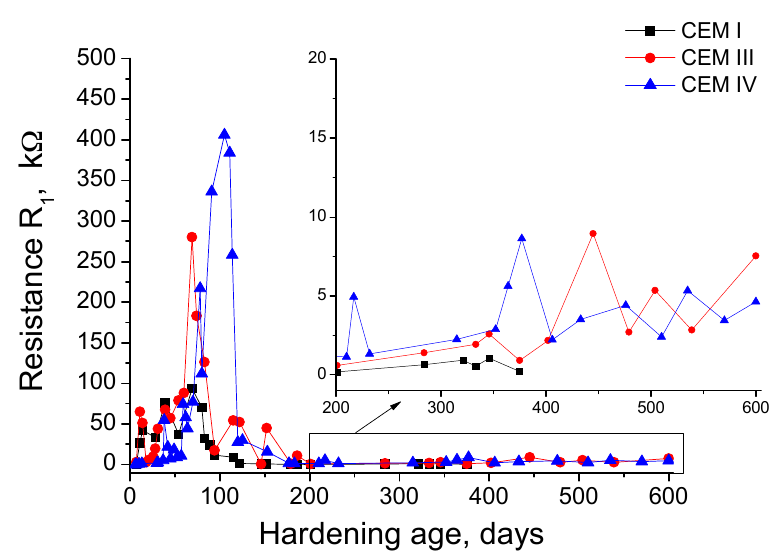
Figure 2. Results of impedance spectroscopy resistance R 1 for CEM I, III and IV grouts.